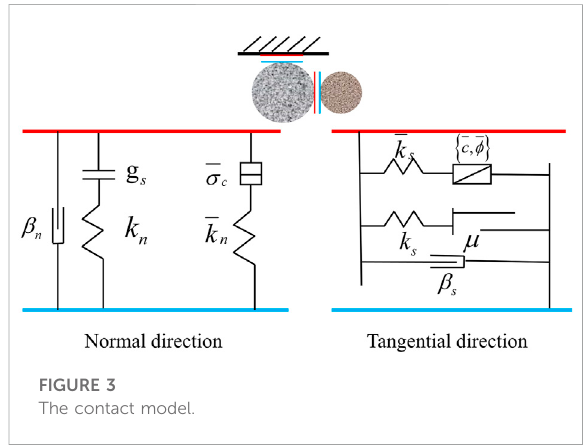
FIGURE 3 The contact model.